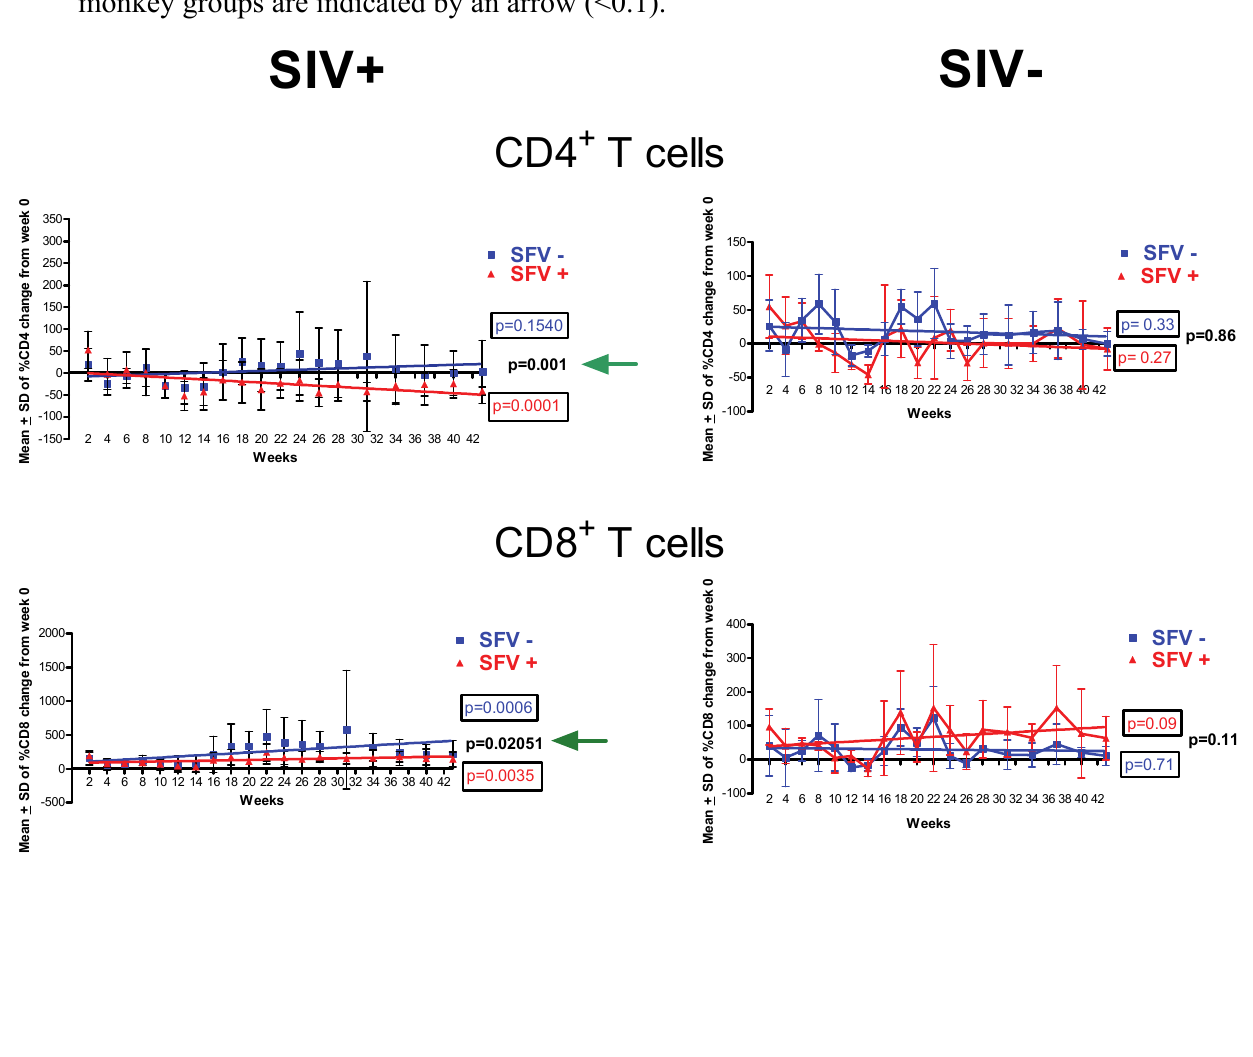
SFV − /SIV+ group of animals. An increasing trend was seen in the CD20 + B cells in the SIV-infected animals, but the difference between the SFV positive and SFV negative groups was not statistically significant ( p = 0.1). Furthermore, there was no statistical difference in the T-cell subsets or B cells between the SFV positive and SFV negative animals in the control SIV negative group. These results indicated that SFV may influence T-cell subsets in SIV-infected macaques. Figure 3. Longitudinal analysis of T and B cells. Linear regression (GraphPad Prism, v5.0, La Jolla, CA, USA) of percent changes in T and B cells in SFV positive and SFV negative monkey groups was done by calculating the percent change in cells as compared to week 0 for each animal at each time point. CD4 + and CD8 + T cell counts and CD20 + B cell counts were determined by flow cytometry using freshly collected blood in EDTA anticoagulant. The groups of SIV positive and control SIV negative monkeys are shown. Mean ± SD was determined based upon the percent change in cells for all of the monkeys at each time point per group. The difference in the slope of the linear regression curve with regard to week 0 is indicated by the boxed p values. The statistically significant p values between the monkey groups are indicated by an arrow